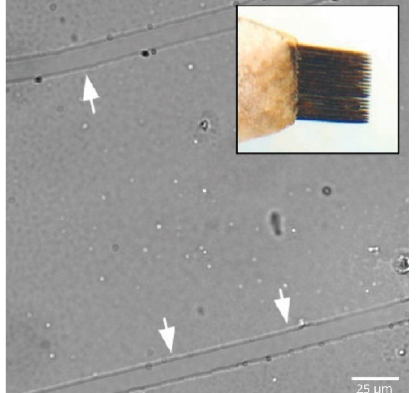
Figure 2. Aligned scratches on PDL-coated culture dish using rake pins for axonal guidance. Representative image of micron-sized scratches applied on poly-D-lysine-coated cell culture plates. Each scratch was approximately 14 μ m in width and spaced approximately 150 μ m apart. Inset shows the pin rake made by cementing together 20 individual insect pins, with each pin placed approximately 200 μ m apart. Scale bar = 25 μ m.